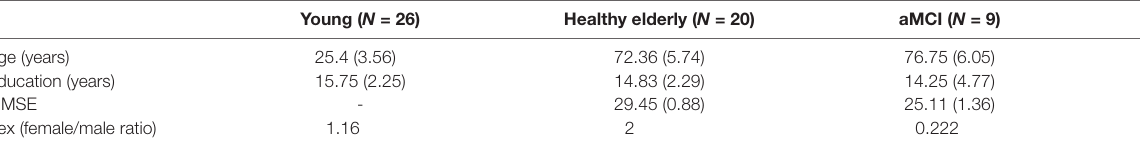
TABLE 1 | Group differences-mean (Standard Deviation).